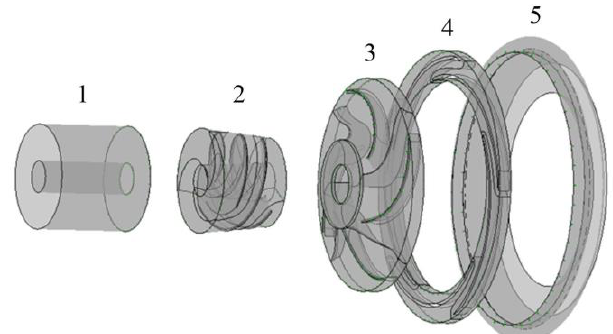
Figure 3. Flow-path of high-speed pump.